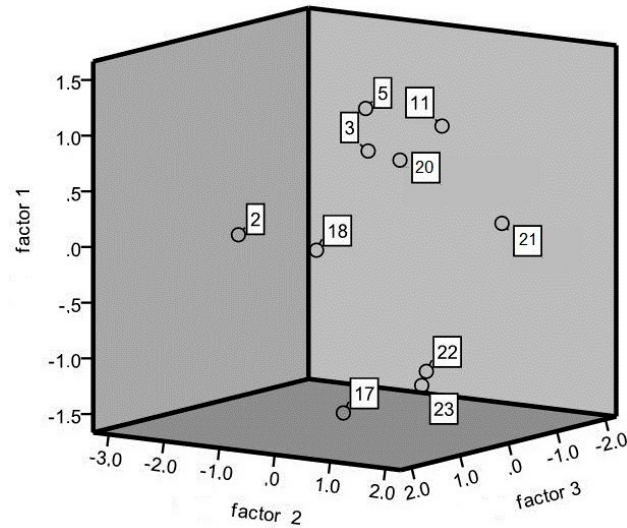
Figure 3. Distribution of the analyzed genotypes against the first three Principal Component functions.